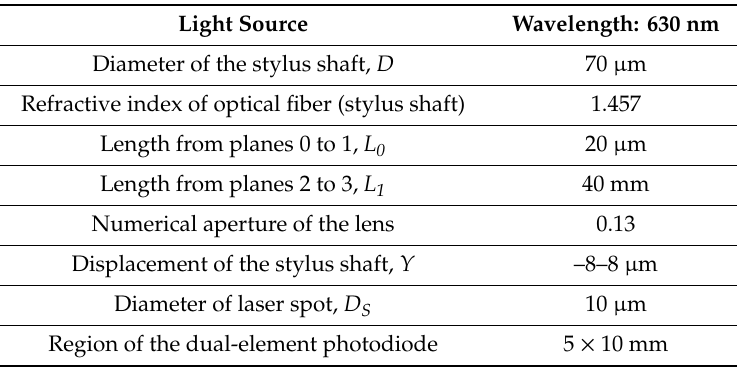
Figure 5. Schematic diagram of the ray-tracing method. Table 1. Conditions of